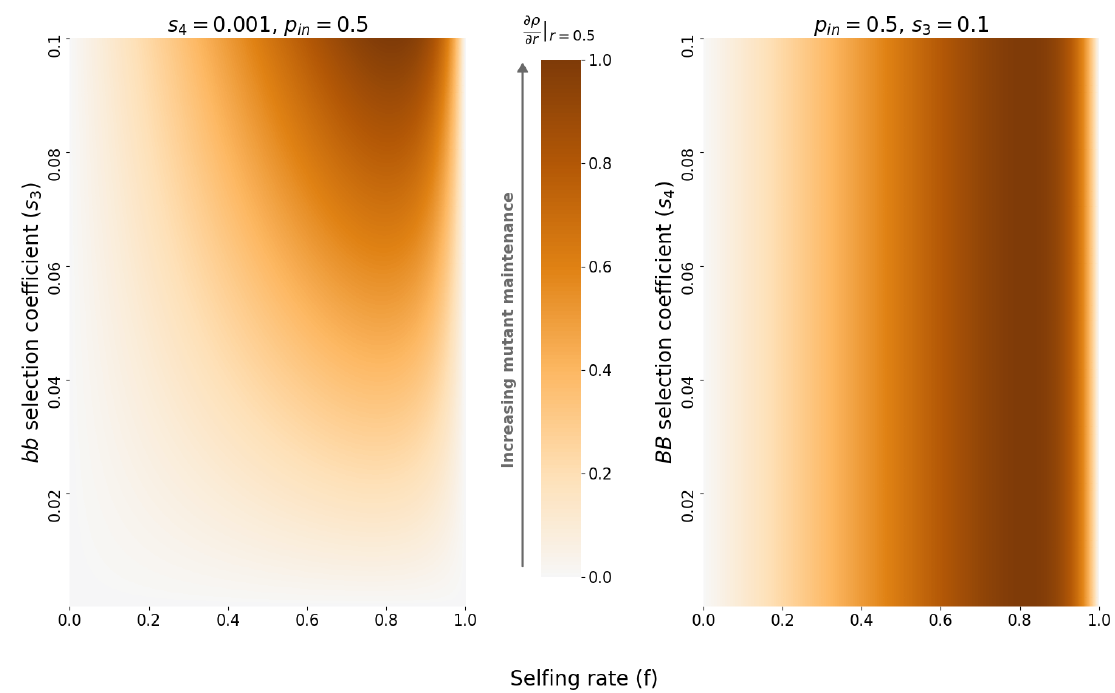
Figure S3 – Relative variation of the derivative of the eigenvalue in the overdominance case, for varying selfing rate f (x-axis), and selection coefficients s 3 (y-axis, left) and s 4 ∂ρ (y-axis, right), with s 3 > s 4 . For each panel, the values of ∂ r | r =0.5 range from a minimal value, which is negative, to zero. We divided each value of the derivative by this minimum in order to plot values between 0 and 1 for every panel. This enables us to compare the impact of different parameters ( s 3 , s 4 and f ) on the sheltering effect of the mating-type locus. The darker the color, the more the mating-type locus shelters the mutation, thus promoting its